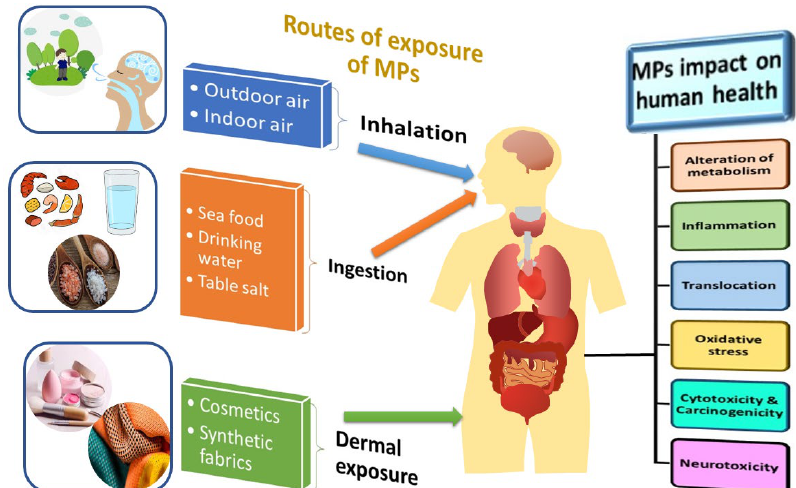
Figure 11. Schematic illustration of exposure of MPs on human health.